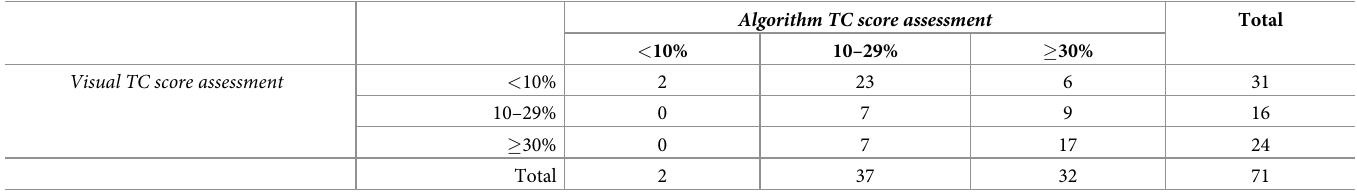
Table 4. Interrater agreement between the visually assessed tall cell (TC) percentage and the algorithm-based TC score in tumor relapse samples.